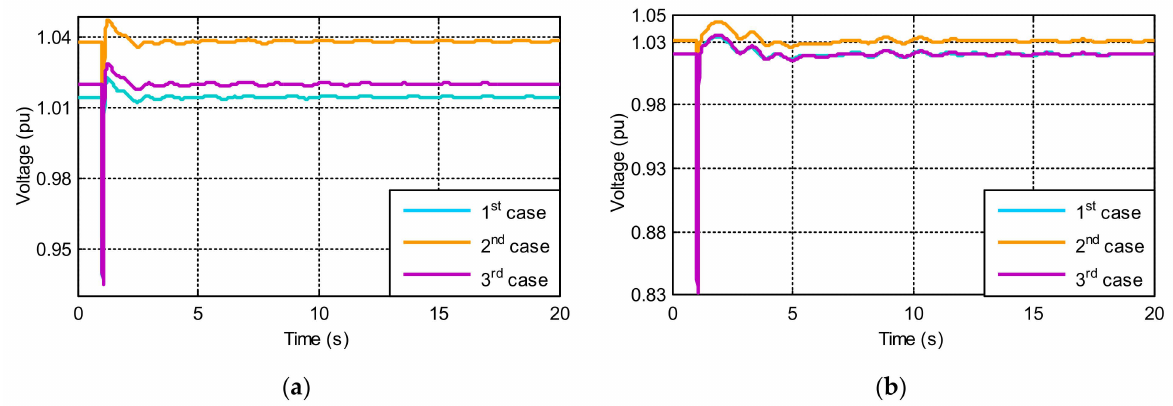
Figure 12. Voltage transient response of the power system versus a simultaneous line and bus distur- bance at different points: ( a ) voltage at bus no. 16840-GQD11; ( b ) voltage at bus no.